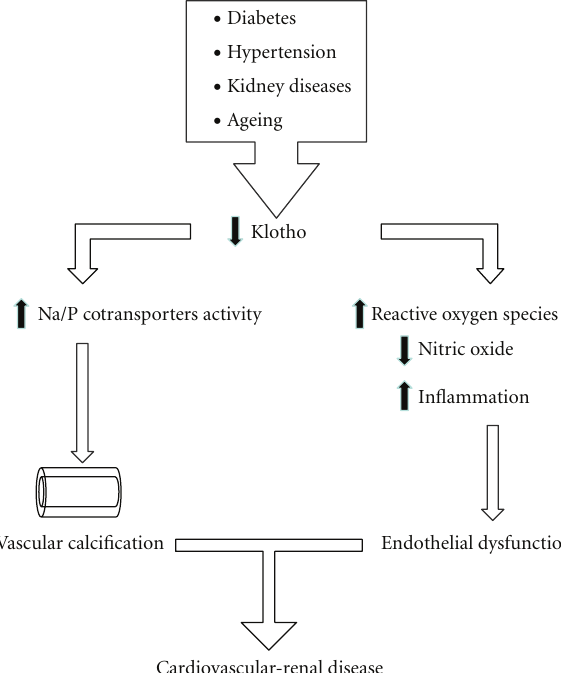
Figure 1: Putative mechanisms by which reduction in Klotho results in cardiorenal